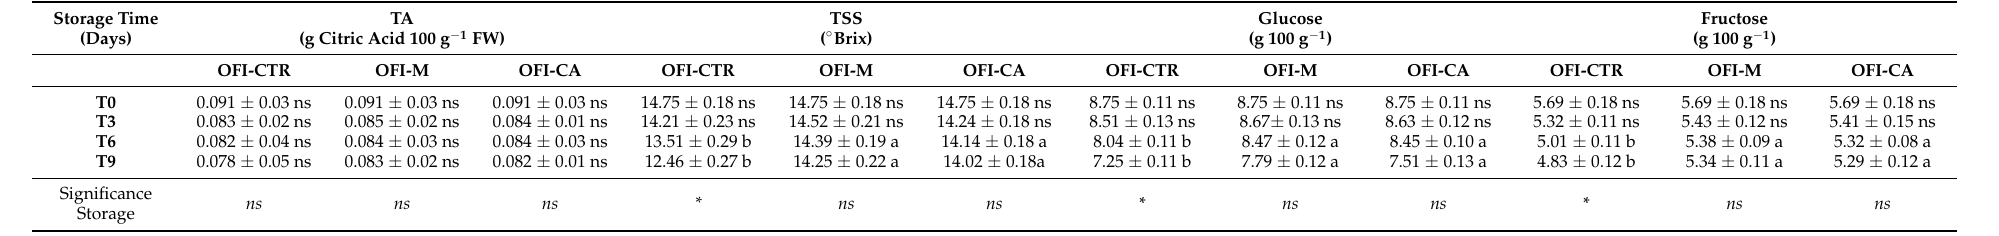
Table 1. Changes in titratable acidity (TA), total soluble solid (TSS), fructose and glucose in minimally processed O. ficus-indica fruits non-treated (OFI-CTR) and treated with mucilage (OFI-M) and calcium ascorbate coating (OFI-CA) during cold storage (9 days at 5 ◦ C). Different lowercase letters indicate significant differences between the treatments in each sampling date. Data are the mean ± SE ( n = 5 ).